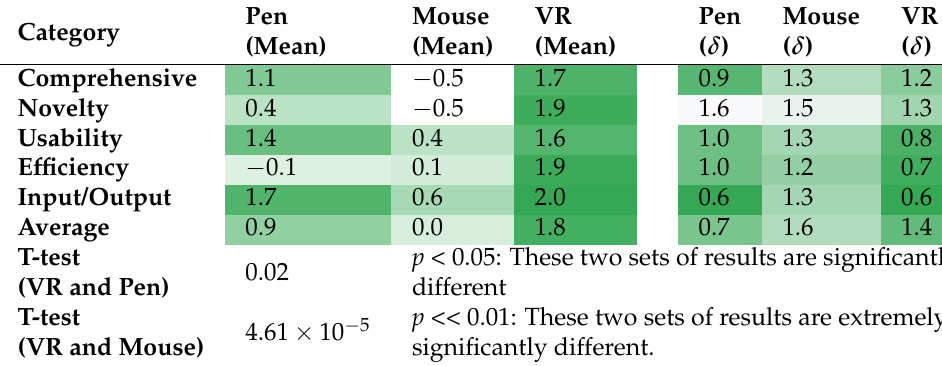
Figure 5. A partial snapshot of the user experience survey scale (questionnaire), containing only two questions as examples. Table 5 lists all questions. Table 6. Results of user experience survey scale (questionnaire) when using a traditional whiteboard (pen), electronic whiteboard (mouse), and the proposed VR